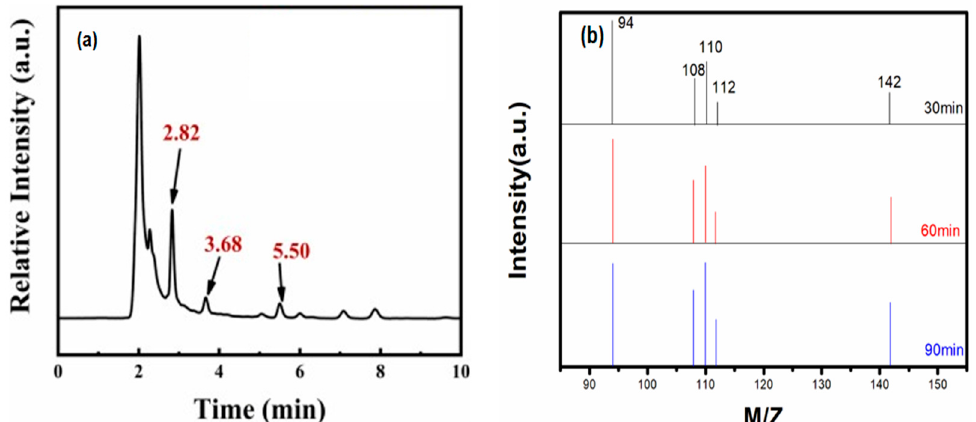
Figure 8. ( a ) Intermediates of phenol degradation and ( b ) mass-to-charge ratio of products after 30, 60, and 90 min of degradation as identified by GC-MS.